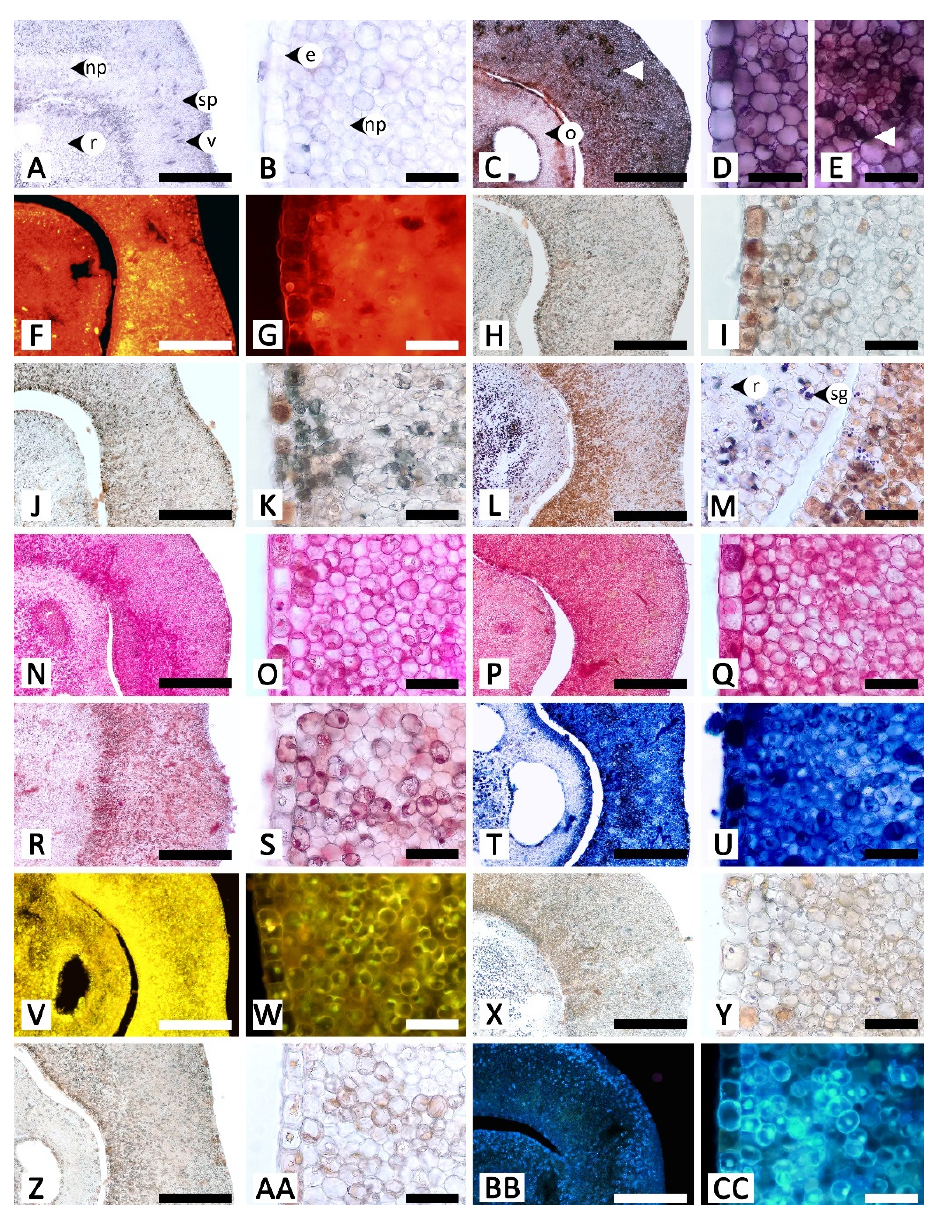
Figure 5. Histochemical results obtained from the nectary disc of Rivea ornata . ( A ) Transversal view and ( B ) close-up view of an unstained nectary disc. ( C – E ) Sudan black B test for total lipids; note cells in the subnectariferous parenchyma presenting intense positive results in accumulated substances (arrowhead). ( F , G ) Neutral red fluorochrome test for total lipids. ( H , I ) Ferric chloride test for phenolic compounds. ( J , K ) Potassium dichromate test for phenolic compounds. ( L , M ) Lugol’s iodine test for starch; note the positive results also present in parenchyma tissue of the receptacle. ( N , O ) Periodic acid–Schiff’s reagent (PAS) test for neutral polysaccharides. ( P , Q ) Ruthenium red test for acidic polysaccharides. ( R , S ) Mercuric bromophenol blue test for proteins. ( T , U ) Nadi reagent test for terpenoids. ( V , W ) Naturstoff reagent A under fluorescent microscopy detecting flavonoids. ( X , Y ) Dragendorff reagent test for alkaloids. ( Z , AA ) Wagner’s reagent test for alkaloids. ( BB , CC ) UV autofluorescence of the nectary disc. Note: ( C – Q , T – AA ) show positive reactions, while ( R , S) show negative reactions. Abbreviations: e, epidermal cell; np, nectariferous parenchyma; o, ovary; r, receptacle; sg; starch grain; sp, subnectariferous parenchyma; v, vascular tissue. Scale bars: ( A , C , F , H , J , L , N , P , R , T , V , X , Z , BB ) 500 µ m; ( B , D , E , G , I , K , M , O , Q , S , U , W , Y , AA , CC ) 50 µ